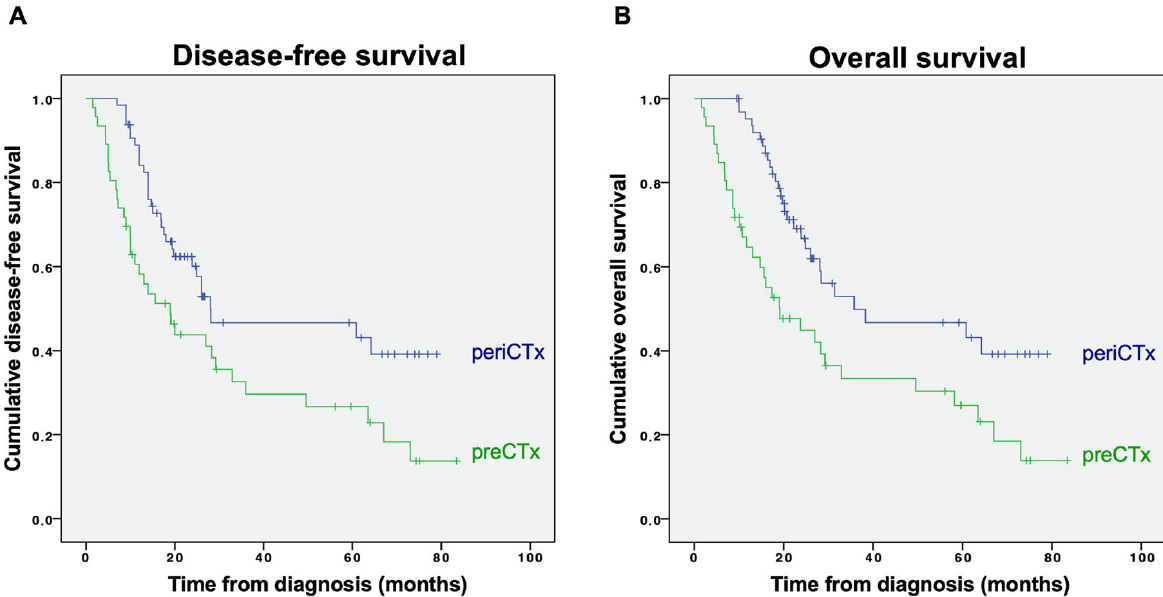
Figure 2. ( A ) Disease-free and ( B ) overall survival for patients receiving perioperative (periCTx, blue line) and preoperative chemotherapy (preCTx, green line) is displayed.